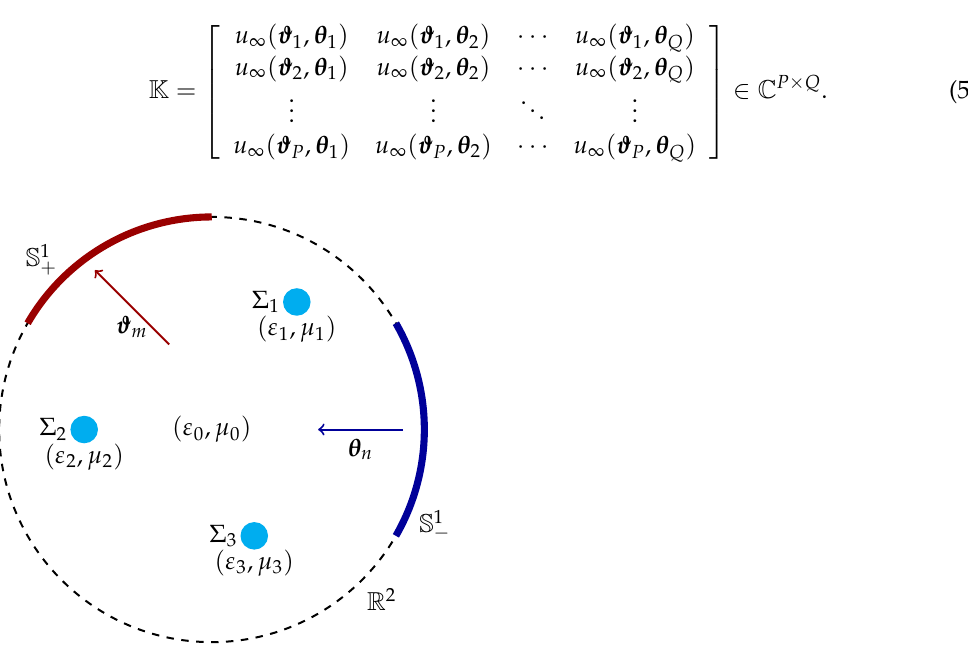
Figure 1. Description of the